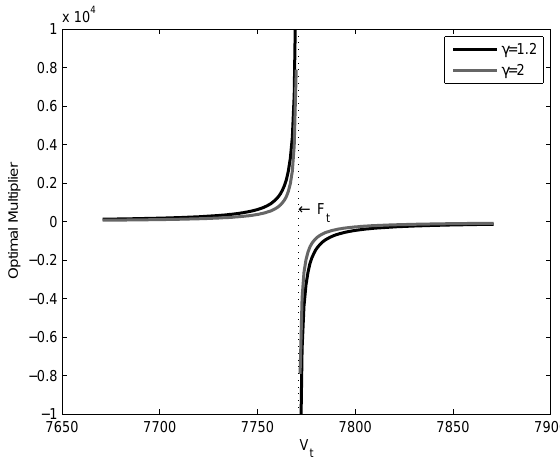
Figure 5. Optimal Multiplier versus Value of the Pension Fund for different values of γ when ( σ = 0.015).